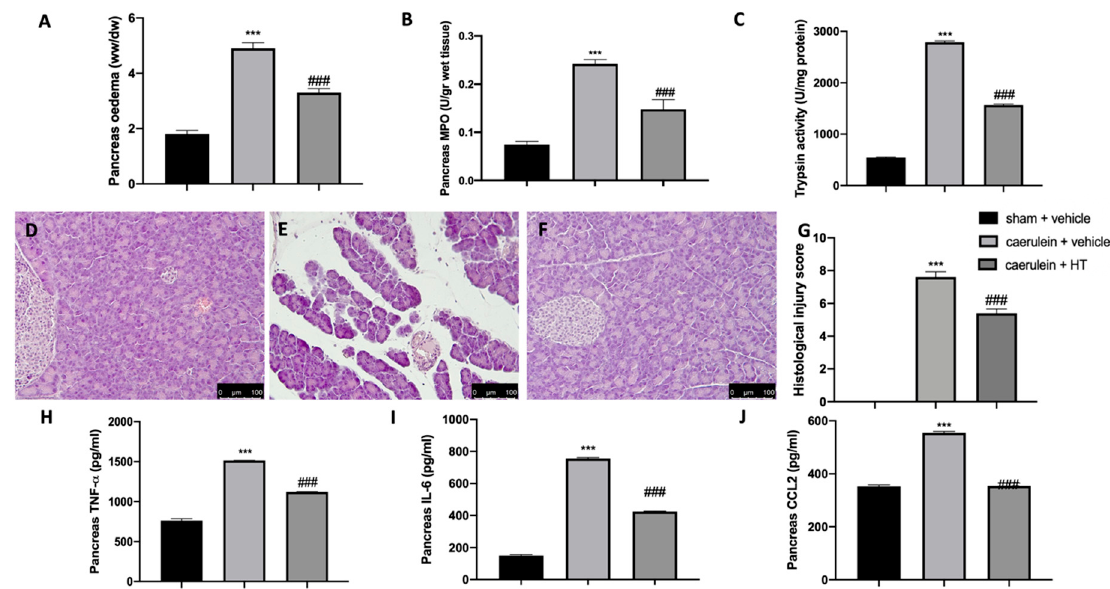
Figure 4. Hydroxytyrosol (HT) effect on pancreas injury induced by caerulein administration: pancreaetic edema ( A ), myeloperoxidase (MPO) activity ( B ), trypsin activity ( C ), pancreas histological analysis: sham + vehicle ( D ), caerulein + vehicle ( E ), caerulein + HT ( F ), histological injury score ( G ), pancreas cytokine expression: tumor necrosis factor alpha (TNF- α ) ( H ), interleukin 6 (IL-6) ( I ), monocyte chemotactic protein-1 (MCP1 / CCL2) ( J ). For each analysis, n = 5 animals from each group were employed. A p -value < 0.05 was considered significant. *** p < 0.001 vs. sham + vehicle, ### p < 0.001 vs. caerulein + vehicle. Scale bar 100 μ m.